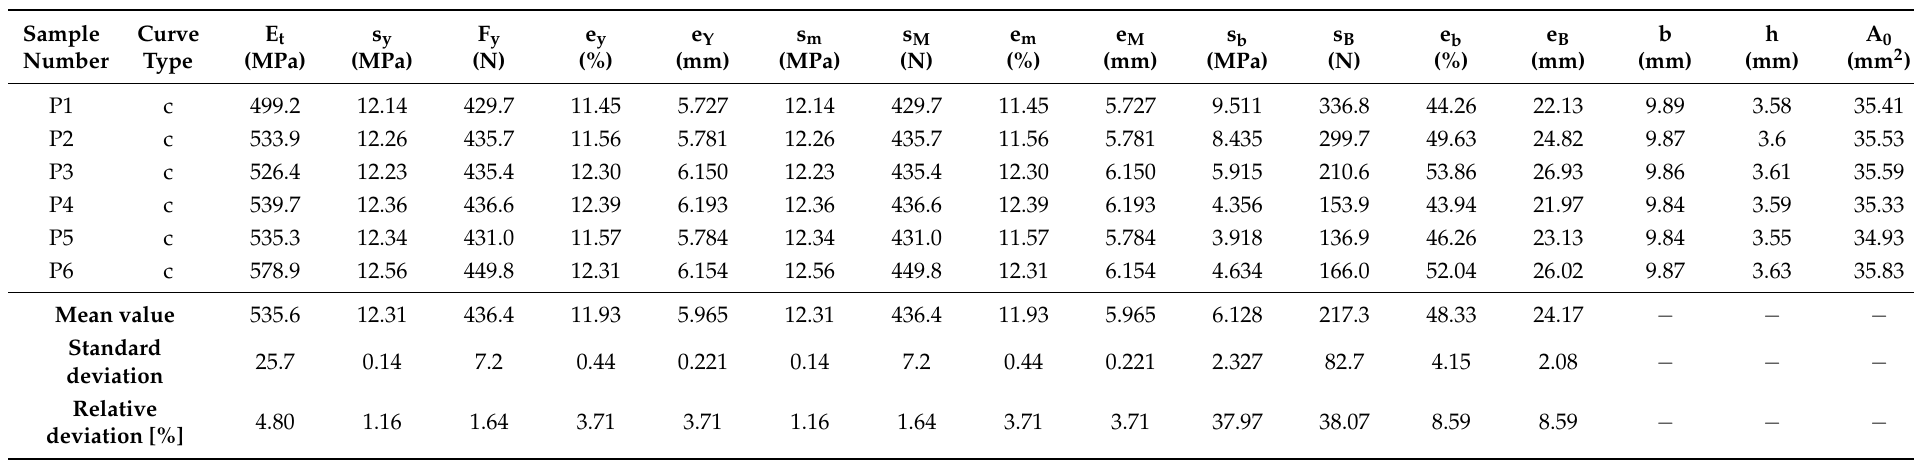
Table A29. Results of the tensile tests of